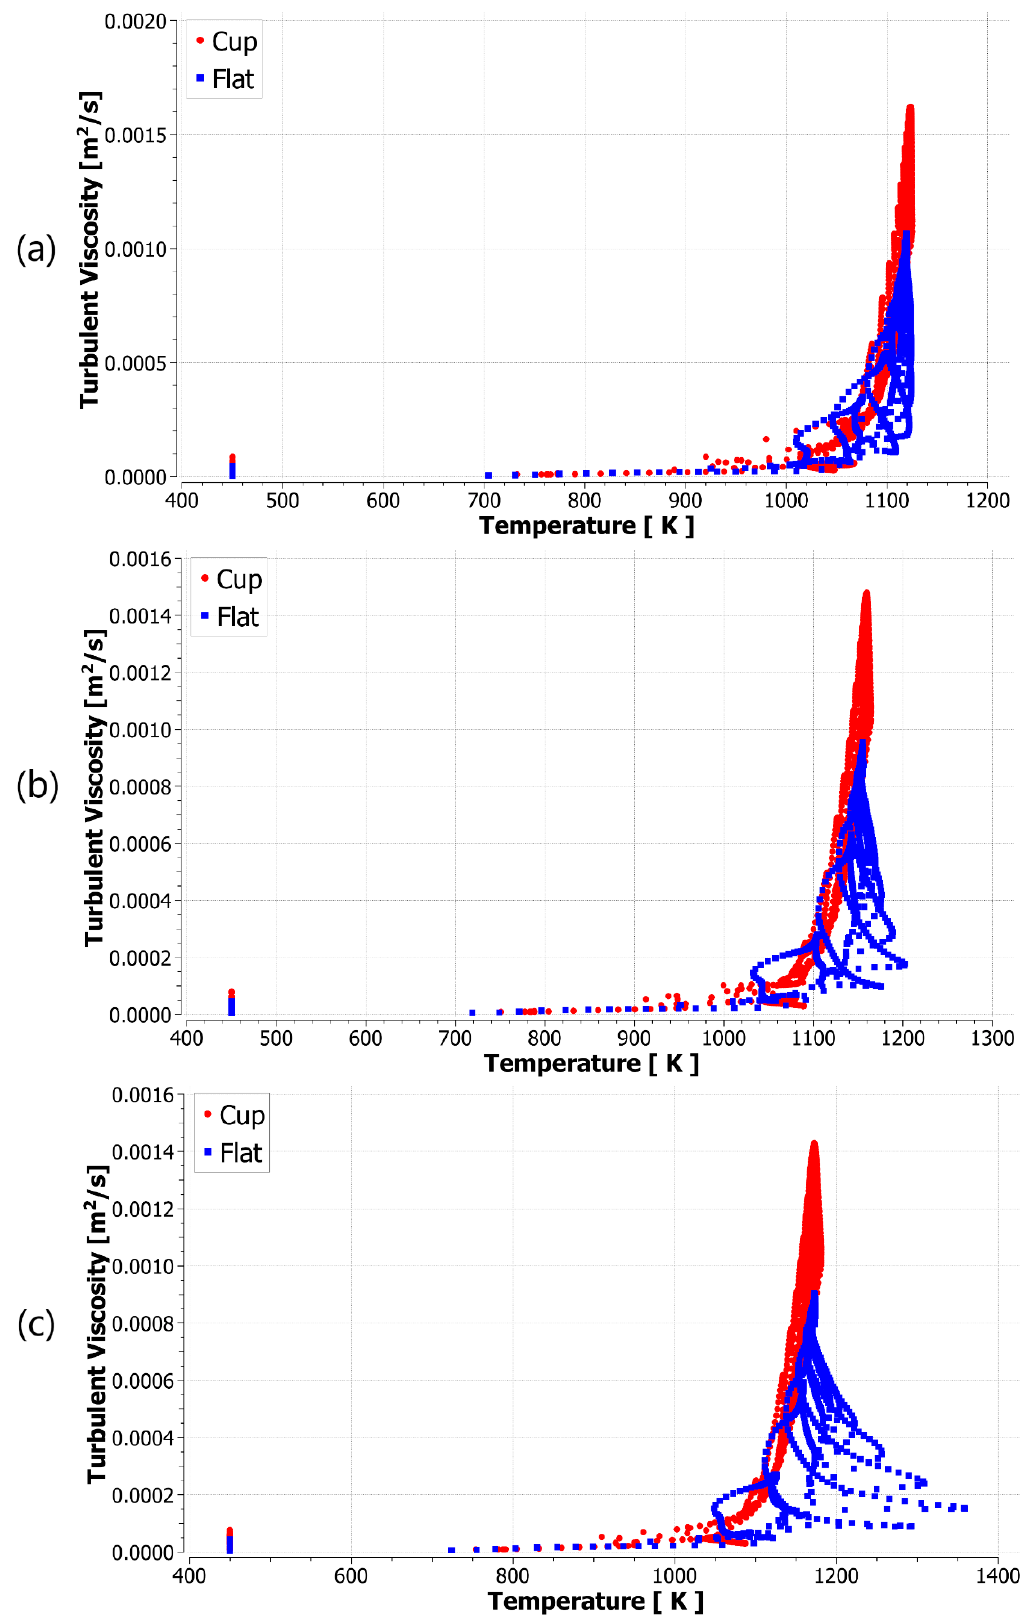
Figure 9. Comparison between the scatter plots of the turbulent diffusivity as a function of gas temperature for the two piston shapes at different crank angles: ( a ) 10 CAD BTDC; ( b ) 5 CAD BTDC; ( c ) 3 CAD BTDC.